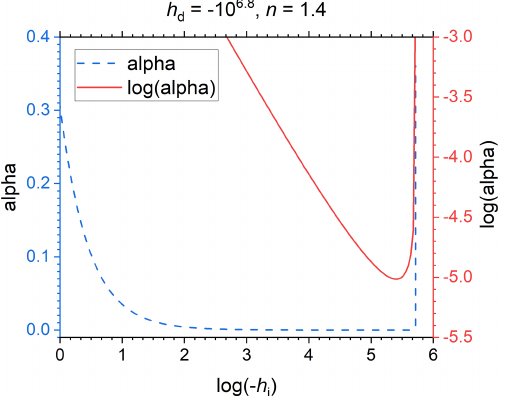
Figure 2. A transect of Fig. 1 for n = 1 . 4 that shows the sharp in- crease of shape factor α (cm − 1 ) as the matric potential at the junc- tion point h j (cm H 2 O) reaches its physical limit defined in Eq. (4).